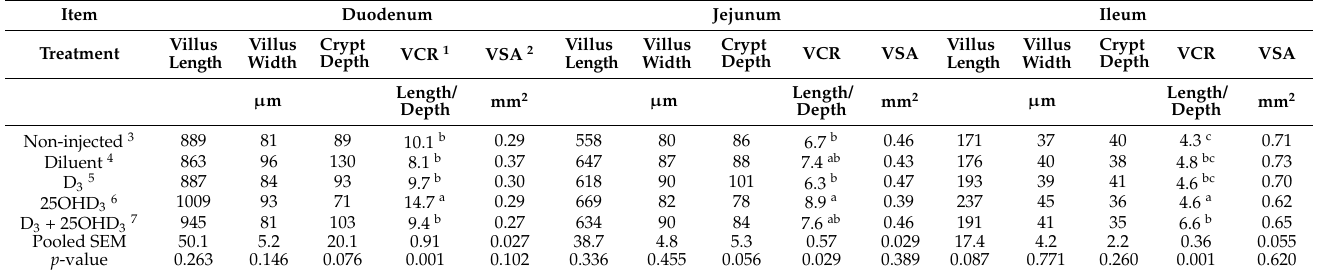
Table 3. Effects of in ovo injection treatment (non-injected, diluent-injected (50 µ L) and 50 µ L of